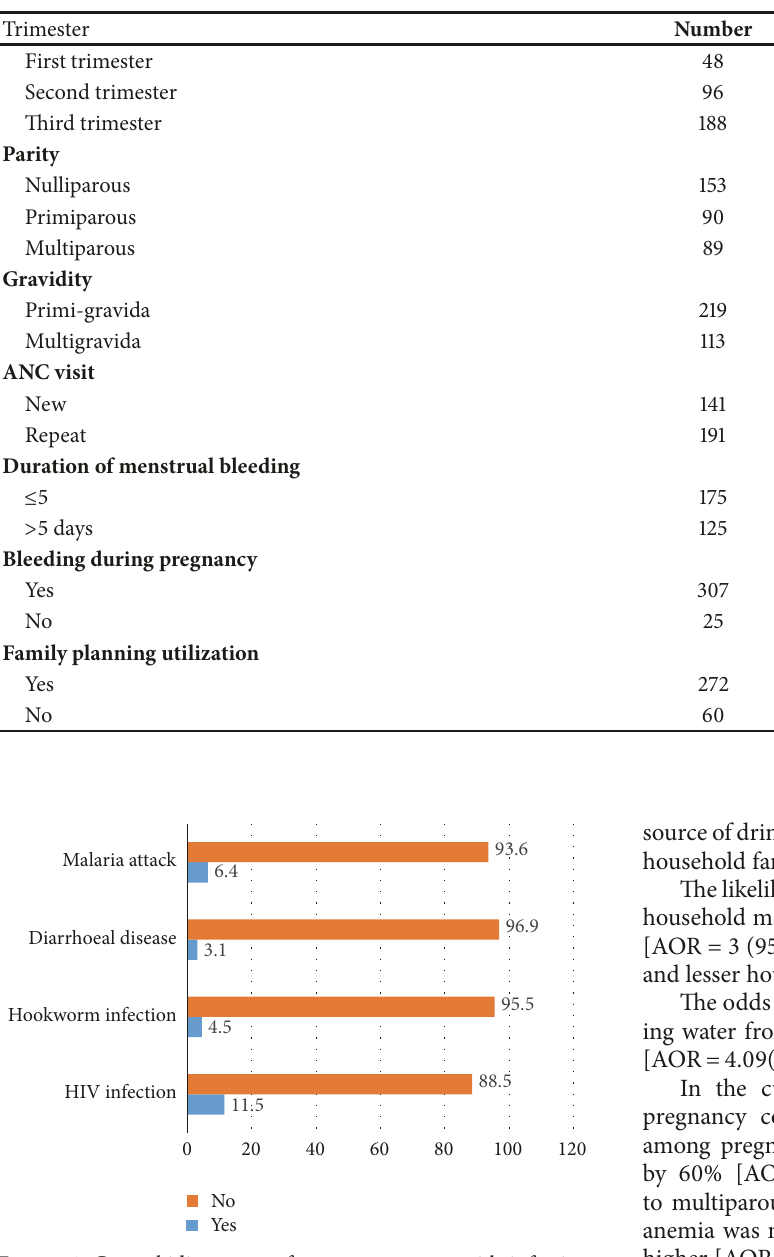
Figure 1: Comorbidity status of pregnant women with infectious disease attending ANC at the University of Gondar Comprehensive and Specialized Referral